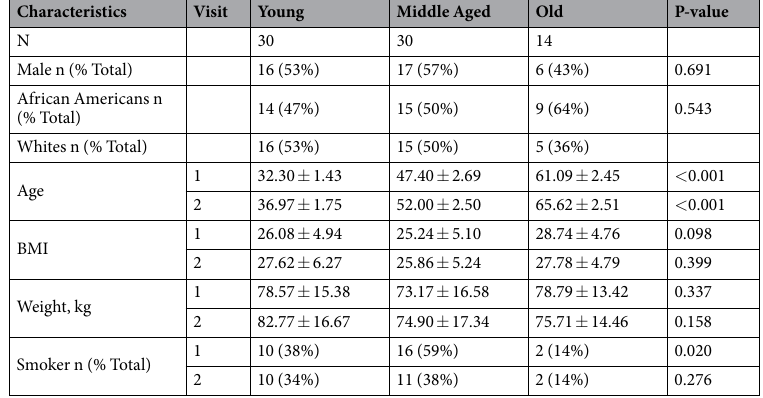
Table 1. Demographic and clinical characteristics of the EV cohort. Age, BMI, and weight represent the mean ± SD. Pearson’s chi-squared tests were used to analyze differences among the age groups for gender, race, and current smoking status. Smoking status was missing for 7 individuals at visit 1 and 2 individuals at visit 2. One-way ANOVAs were used to analyze differences among the age groups for BMI, weight and